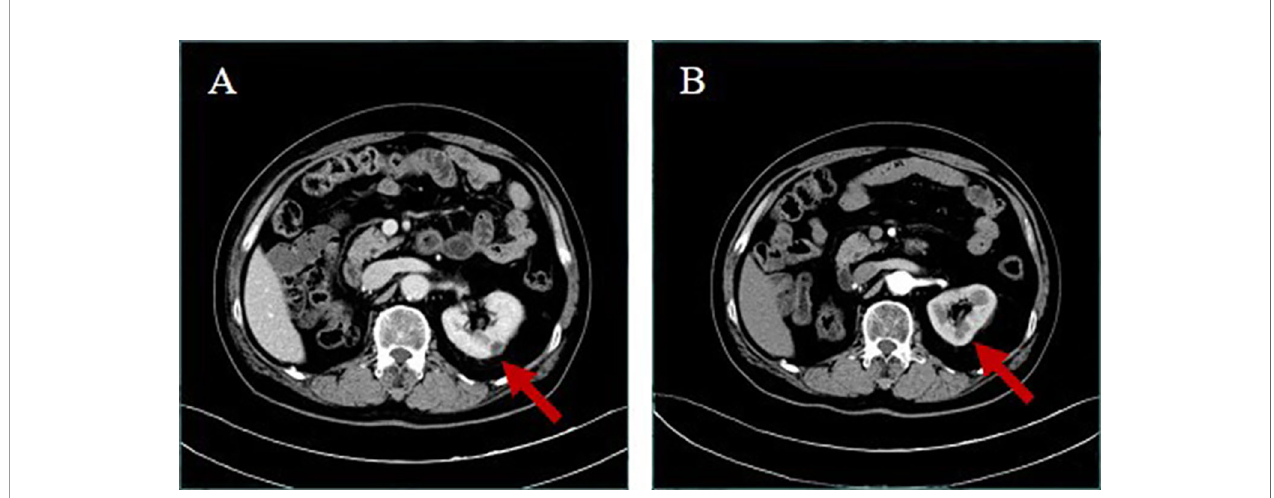
FIGURE 4 | Upper abdominal enhanced CT (A) in December 3, 2020; the right kidney was not shown and the left kidney appeared to have a new low-density mass, about 11 mm in diameter, with marginal enhancement. (B) In February 18, 2021, after more than 2 months of crizotinib withdrawal, the patient revealed that the abnormal enhancement of the left kidney was not obviously